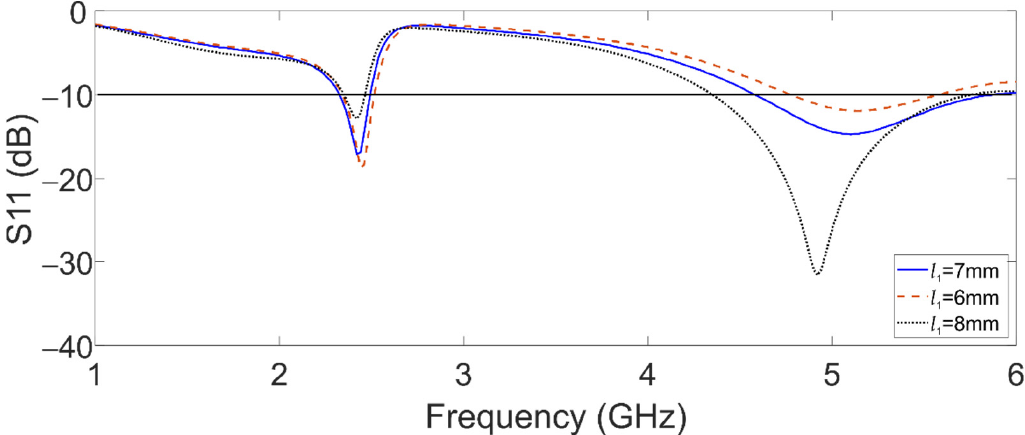
Figure 4. Simulated reflection coefficient of the dual-band graphene antenna for l 1